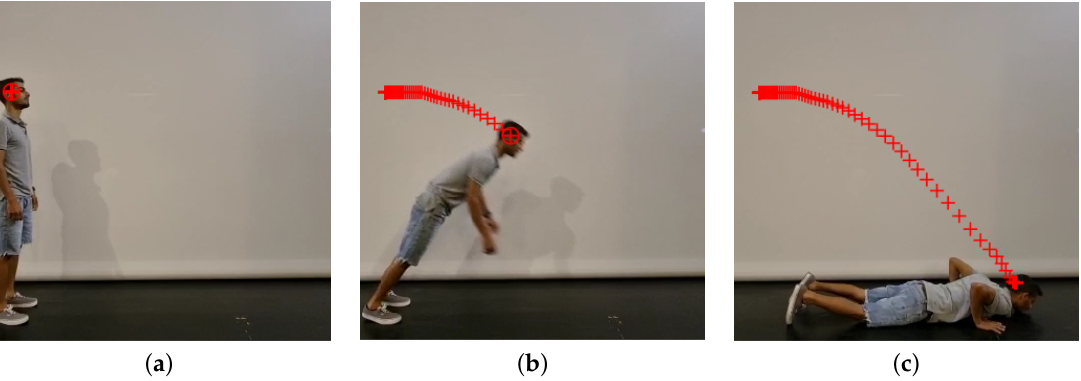
Figure 7. Process for the video analysis of a falling man, tracking head motion: ( a ) standing; ( b ) falling; ( c ) lying